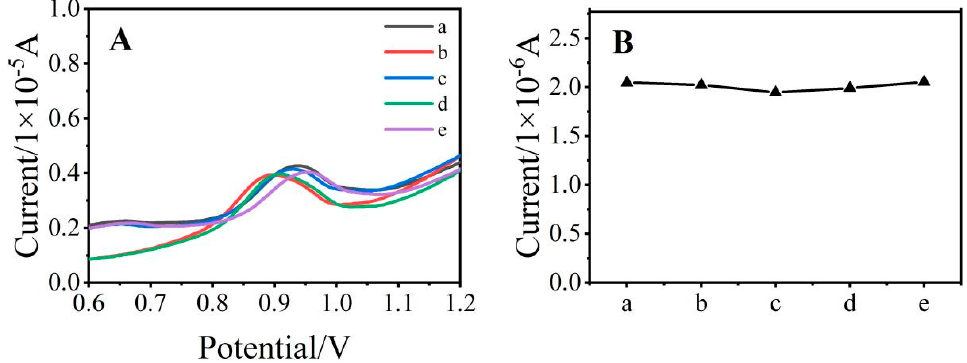
Figure 6. Differential pulse diagram ( A ) and current response ( B ) of the same electrode for SDZ detection five times (50 μ mol/L, ( a – e ) are first to fifth).